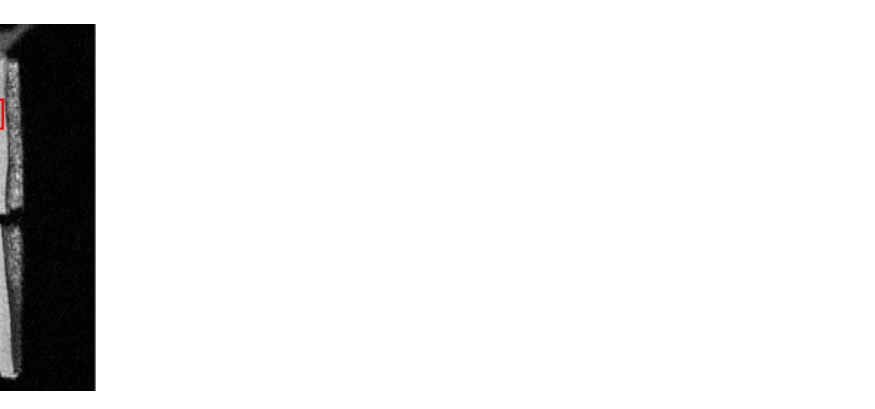
Figure 3. A representative UTE MR image of four patellar cartilage sections to indicate one Region of Interest (ROI). The red rectangle indicates one sample of the ROIs to acquire values of the UTE MR images.